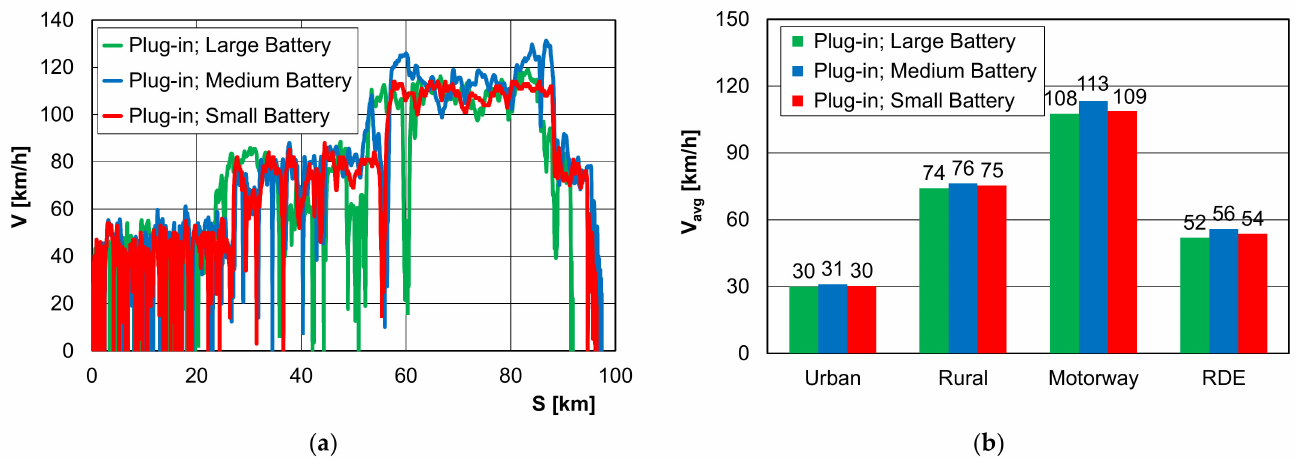
Figure 2. The tracings of the speed in the tests performed on the plug-in hybrids of different battery capacities ( a ) and average values of the speed in each phase of the test and in the entire RDE test ( b